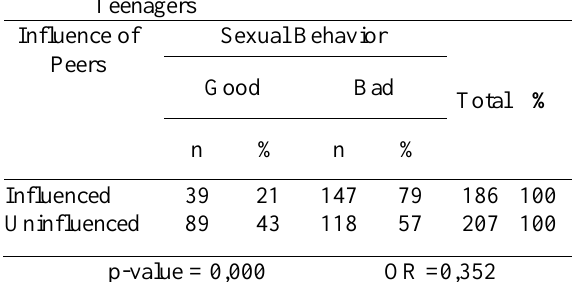
Table 1. Distribution of Correlation Between Influence of Peers with Sexual Behavior among